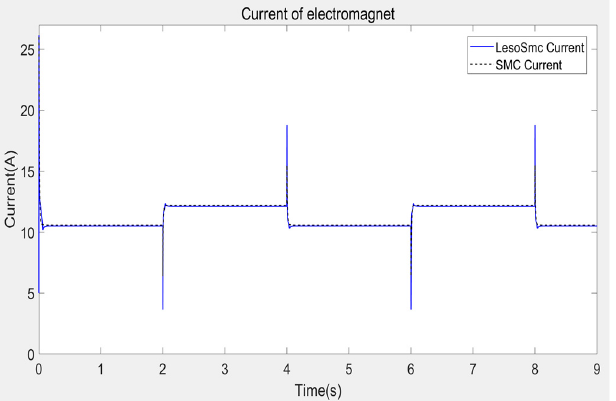
Figure 16. Current of electromagnet under SMC and LESOSMC.